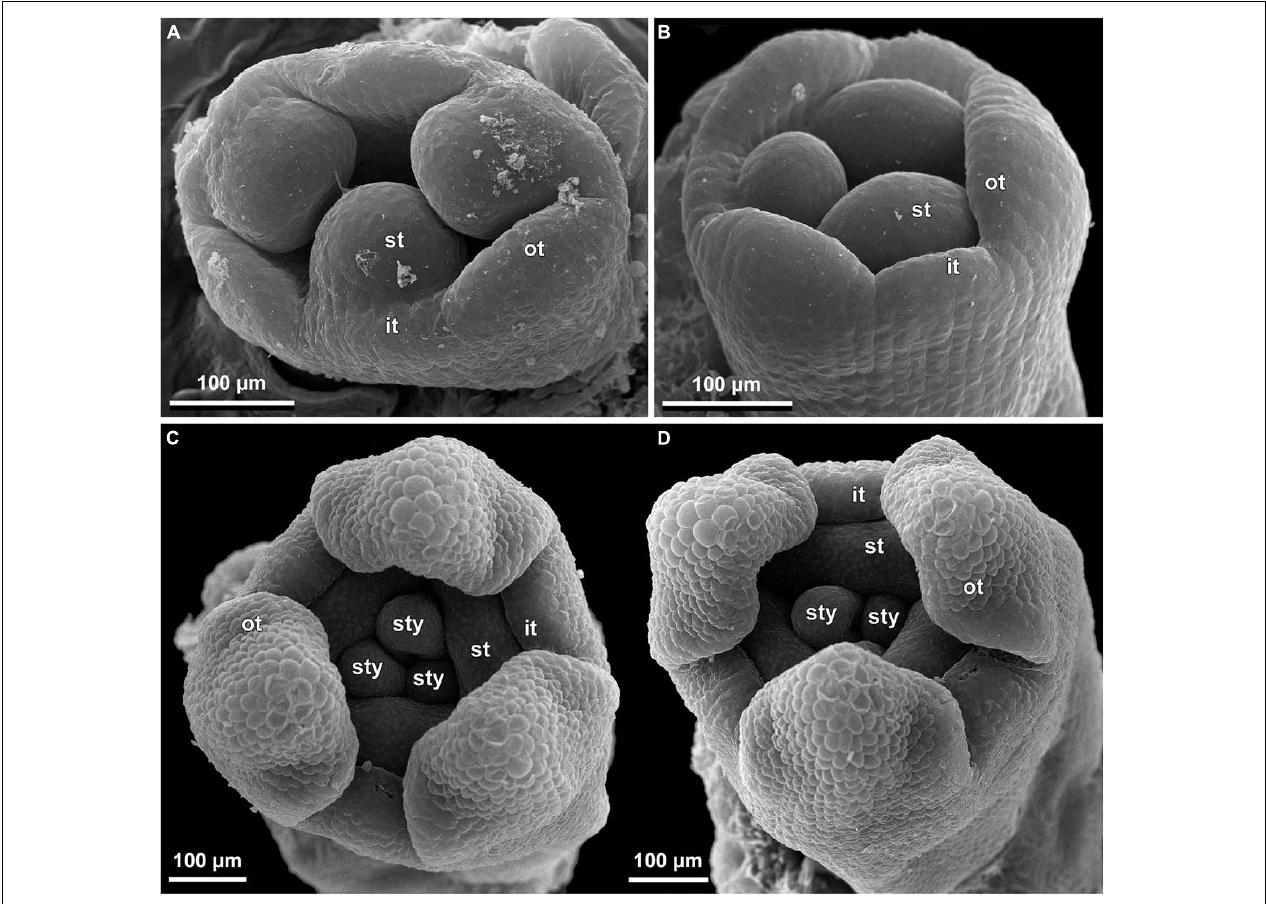
FIGURE 15 | Floral development of Burmannia oblonga (SEM) ( Nuraliev, Lyskov NUR 3160 ). (A) Flower at initiation of inner tepal lobes and stamens on their common primordia. (B) Flower at a stage slightly later than in (A) . (C,D) Flower at initiation of styles (one style shorter than the two others). it, inner tepal; ot, outer tepal; st, stamen; sty,